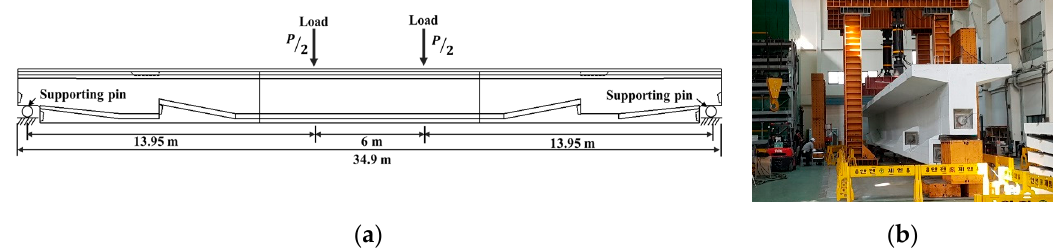
Figure 17. Static loading test of PSC I-girder: ( a ) 4-point bending test set up; ( b ) photograph of actual test.